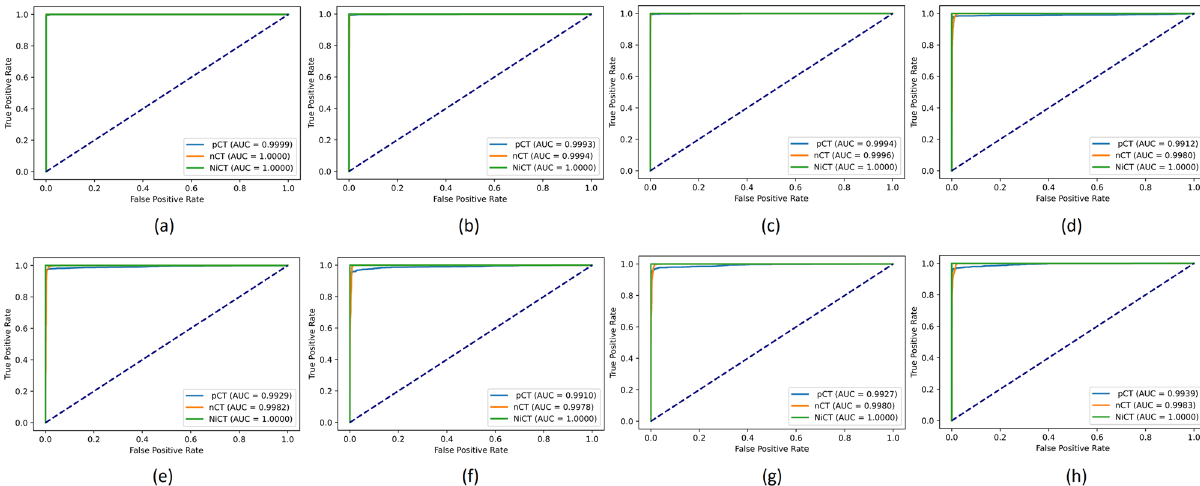
Figure 3. ROC curves generated by our technique on dataset HUST. ( a ) Protocol I, ( b – h ) Protocol II with different imbalance ratios (IR) = 5, 10, 15, 25, 30, 40, and 50,